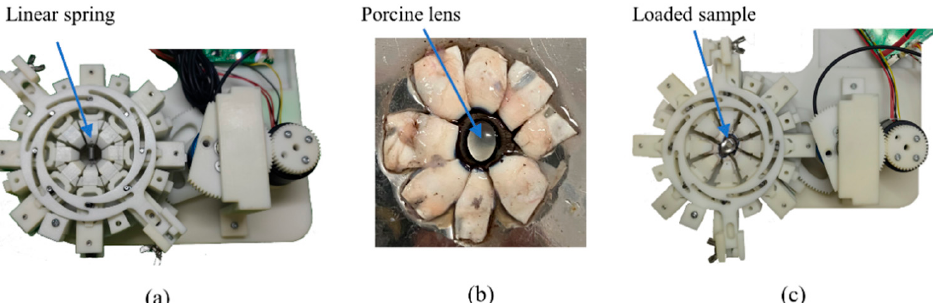
Figure 3. Experimental setup for ( a ) the spring-based validation test; ( b ) the prepared anterior porcine eye sample and ( c ) the porcine-eye-based feasibility test using the proposed stretcher.